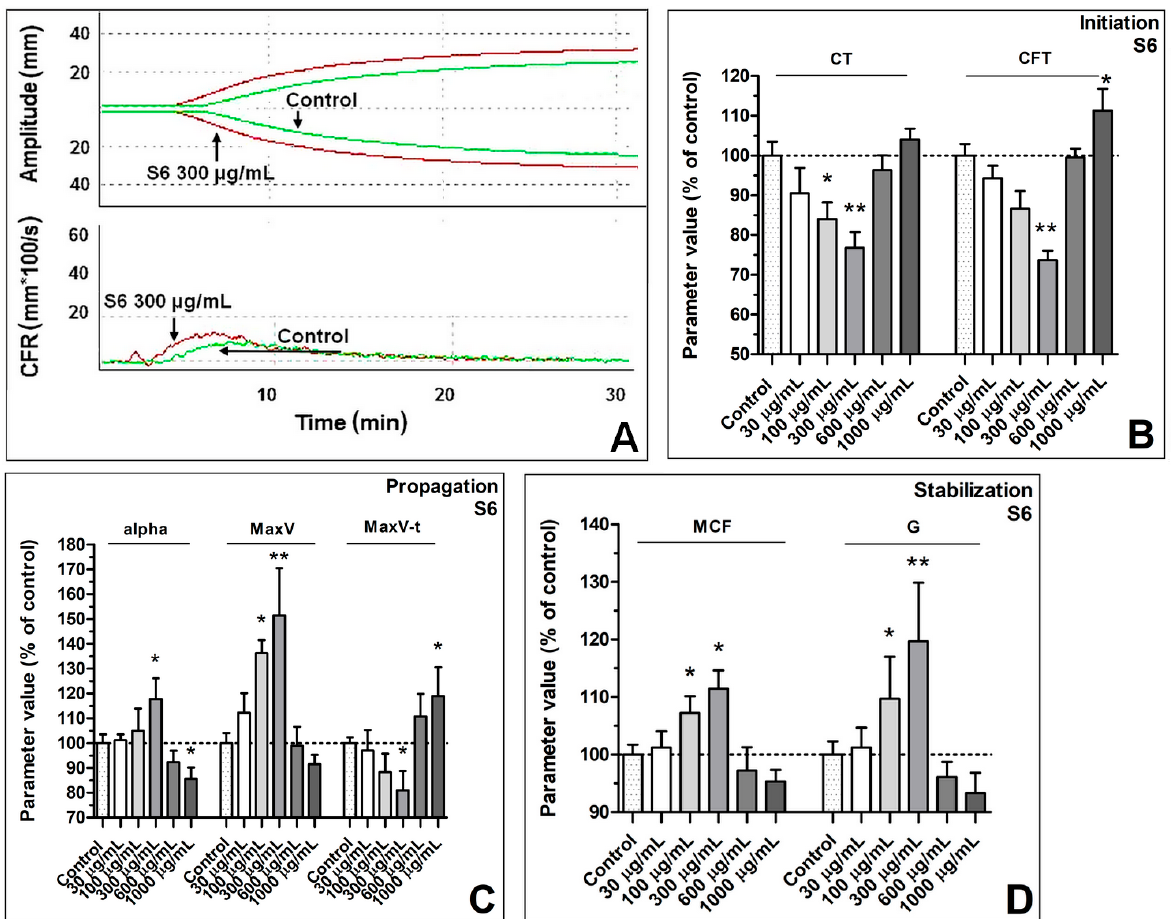
Figure 1. Effect of fraction S6 on the formation kinetics and viscoelastic properties of fibrin clot. Samples of human fibrinogen were incubated without (control) or with the indicated concentrations of S6 for 10 min at room temperature. Next, clotting was initiated by mixing the samples with the activating mix containing bovine thrombin and CaCl 2 (final concentrations of activators: 0.1 U/mL and 10 mM, respectively), and the formation kinetics and viscoelastic properties of the clot were determined using rotational thromboelastometry. Representative coagulation profiles (showing increase of clot firmness over time, the upper part) and record of the clot formation rate (CFR, the distribution of the velocity of clot formation in time, lower part) from one experiment (out of 7) are presented for control sample and selected S6 concentration in panel A . ( B – D ) Parameters associated with clotting initiation (CT, clotting time; CFT, clot formation time), propagation (alpha angle; MaxV, maximal velocity of clot formation; MaxV-t, time to reach maximal velocity of clotting), and stabilization (MCF, maximum clot firmness; G, shear elastic modulus strength) were measured. Data are means ± SD from n = 7 experiments The parameter value range (and mean value ± SD) in the control was CT: 254–363 s (309 ± 52 s); CFT: 210–276 s (243 ± 33 s); Alpha: 34–40 degrees (37 ± 3 degrees); MaxV: 3–5 mm*100/s (4 ± 1 mm*100/s); MaxV-t: 392–468 s (430 ± 38 s); MCF: 22–26 mm (24 ± 2 mm); G: 1410–1756 (1583 ± 172); * p < 0.05; ** p < 0.01.